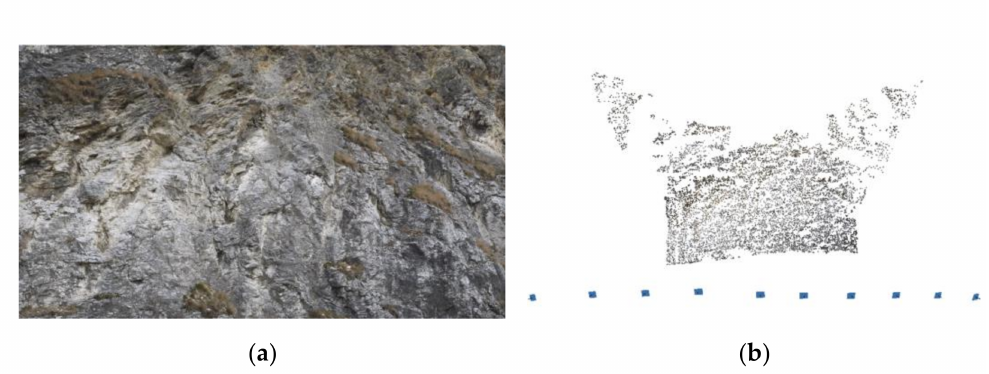
Figure 4. ( a ) Preview image of the rock from the calibration video; ( b ) resulting 3D scene with tie points and